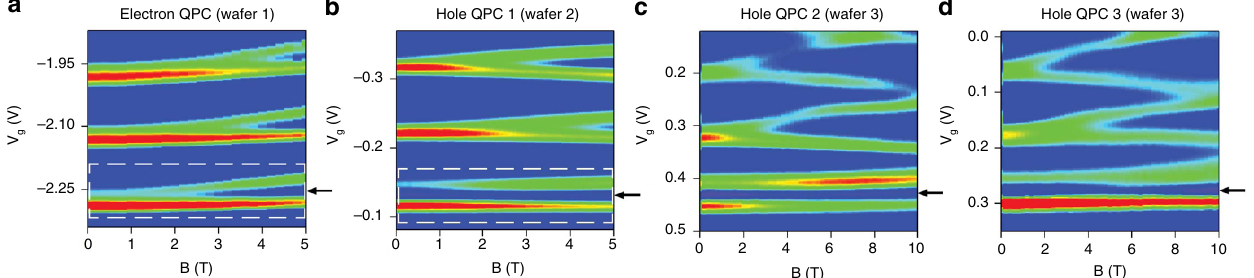
Fig. 2 Measured transconductance ∂ G / ∂ V g of the fi rst three 1D subbands for electrons and holes in QPCs, as a function of energy (gate voltage) and magnetic fi eld. a Experimental data from an electron QPC, showing a transconductance colour map of the Zeeman spin splitting of the fi rst three 1D subbands as a function of gate voltage V g and magnetic fi eld B . Dark-blue regions correspond to conductance plateaus, and the green to red regions correspond to conductance risers (which mark the subband edges). The dashed white boxes in ( a ) and ( b ) mark the fi rst subband and are examined in greater detail in Fig. 3. Each subband splits linearly in magnetic fi eld, including the 0.7 anomaly (indicated by the black arrow). b – d Experimental transconductance colour maps of the Zeeman spin splitting of the fi rst three 1D hole subbands for hole QPCs 1 – 3. In all the cases, subbands 2 and 3 spin- split linearly in magnetic fi eld, whereas the fi rst hole subband is only weakly affected by the magnetic fi eld. differences between electrons and holes become very clear; the fi rst 1D electron subband has a weakly resolved 0.7 anomaly Fig. 1f – h and transconductance behaviour in Fig. 2b – d is repro- structure at B = 0 that splits in magnetic fi eld. In contrast, the duced for a further three hole QPCs in Supplementary Infor- fi rst 1D hole subband has a strongly resolved 0.7 anomaly mation Section 4, and has also been observed in previous studies, structure at B = 0 that does not broaden in energy as magnetic although it has remained unexplained 21,25,26 . fi eld increases, along with the two transconductance peaks that do In Fig. 3a we zoom in on the fi rst 1D electron subband from Fig. 2a, and compare it directly to Fig. 3b where we zoom in on not split. the fi rst 1D hole subband of hole QPC 1 from Fig. 2b. In both The apparent suppression of the spin-splitting in the fi rst 1D Fig. 3a and b, the gate voltage and magnetic fi eld axes have been hole subband is unexpected, since the magnetic fi eld strongly scaled with Ω x to allow comparison with theory. Close up, the affects the conductance of the fi rst 1D hole subband, as shown in